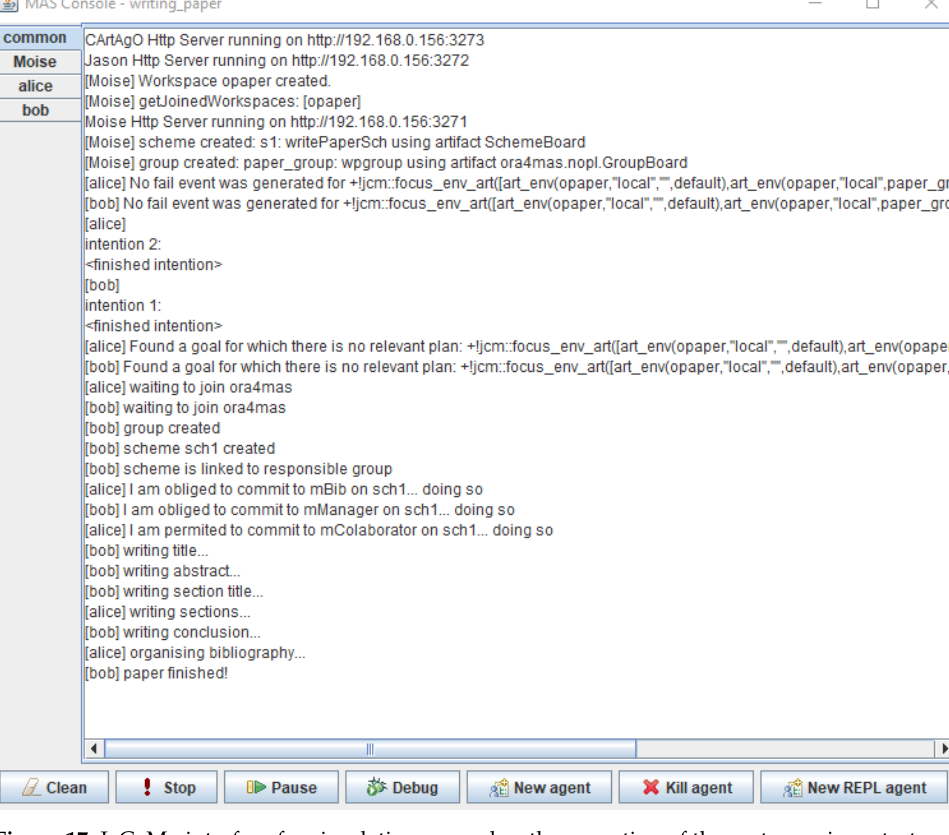
Figure 17. JaCaMo interface for simulation example—the execution of the system using a test